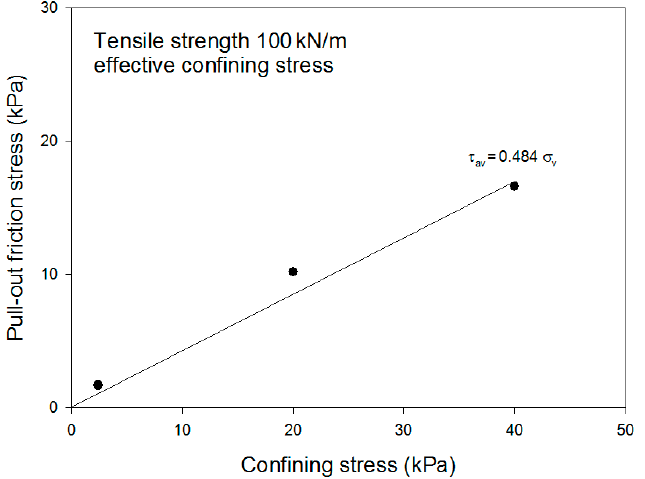
Figure 11. Relationship curve between confining stress and pullout frictional stress by effective confining stress (T g = 100 kN/m).